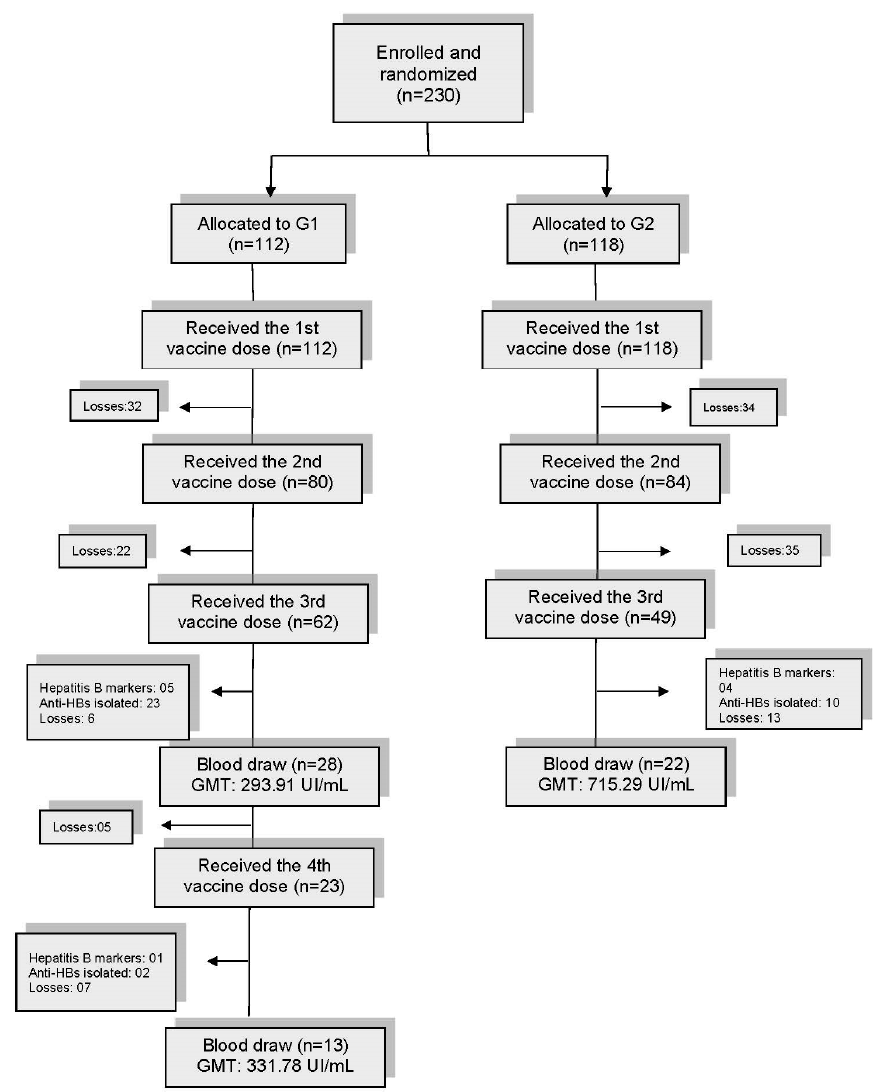
Figure 1. Flowchart of hepatitis B vaccination.